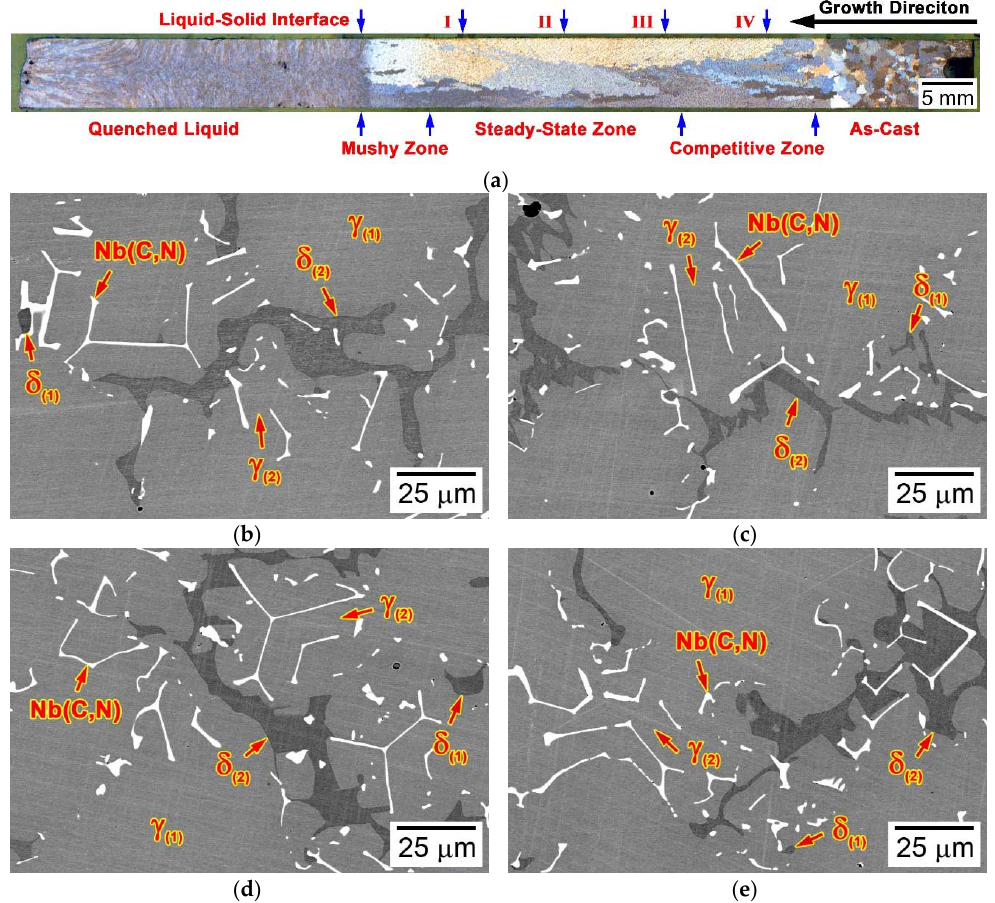
Figure 7. ( a ) Optical image of alloy 2C2N showing the liquid-metal quenched longitudinal macro-grain structure of the DS bar after the LMC-DS processing; SEM-BSE images were taken at distances of ( b ) 10, ( c ) 20, ( d ) 30, and ( e ) 40 mm away from the liquid-solid interface in Figure 7a, showing the microstructural evolution in the steady-state zone and the competitive zone.